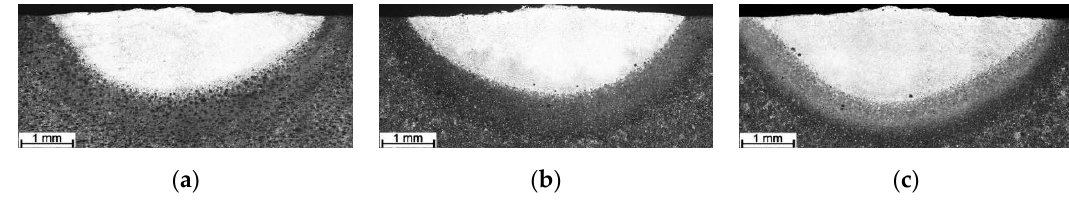
Figure 1. Optical macrographs of the SABs produced using a powder mixture of 80Ti-20Cr (weight ratio); SAB no. (Table 2): ( a ) TC1, ( b ) TC2, ( c ) TC3.